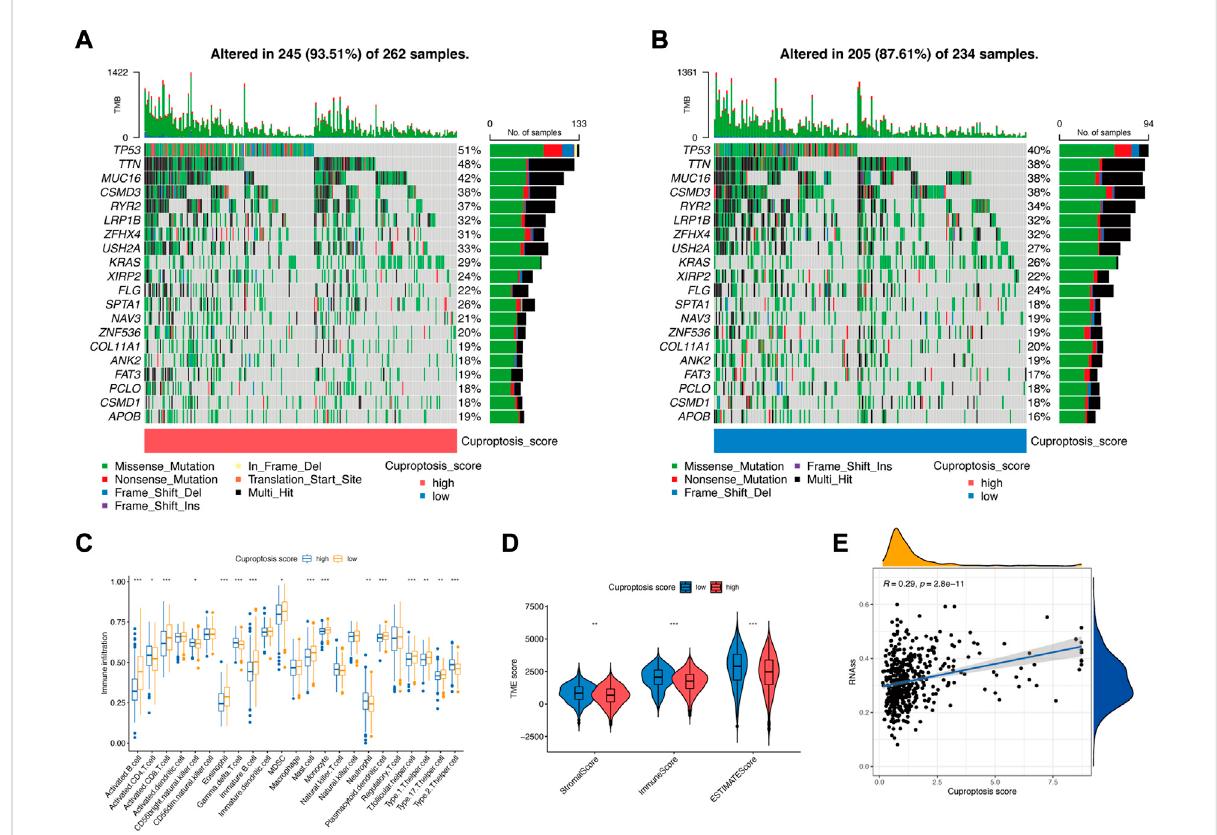
FIGURE 7 Characteristics of the cuproptosis signature. (A) Somatic mutations in the high cuproptosis score group. (B) Somatic mutations in the low cuproptosisscore group. (C) TME-in fi ltratingcellcompositionbetweenhighandlowcuproptosisscoregroups(Wilcoxon test;* p < 0.05;** p < 0.01; *** p < 0.001). (D) ESTIMATE score in the low and high cuproptosis score groups (Wilcoxon test; * p < 0.05; ** p < 0.01; *** p < 0.001). (E) Spearman correlation analysis between the stemness score (RNAss) and cuproptosis